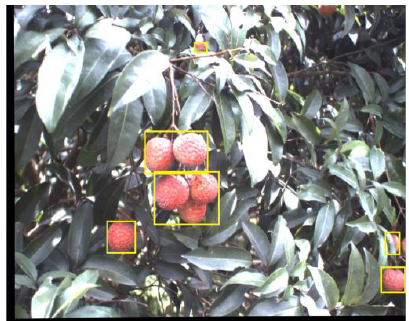
Figure 9. Image of categories recognition of clustered litchi fruit.